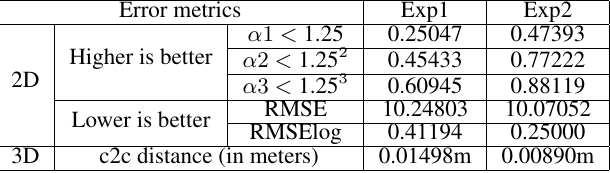
Table 1. Quantitative comparison